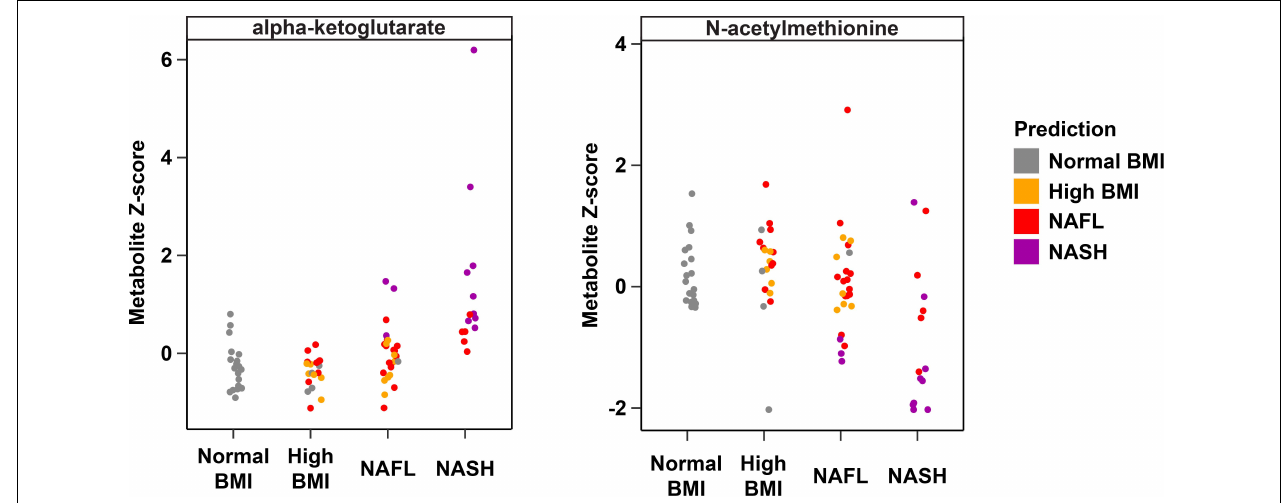
FIGURE 4 | Plasma metabolite drivers of disease cohort misclassification. Ground truth classes based on original clinical diagnosis are shown along the x-axis, predicted classes are shown as the indicated colors, and each point represents one individual. For example, three subjects in the NAFL group who were misclassified as NASH (purple points in the “NAFL” x-axis group) show elevated levels of alpha-ketoglutarate consistent with the NASH